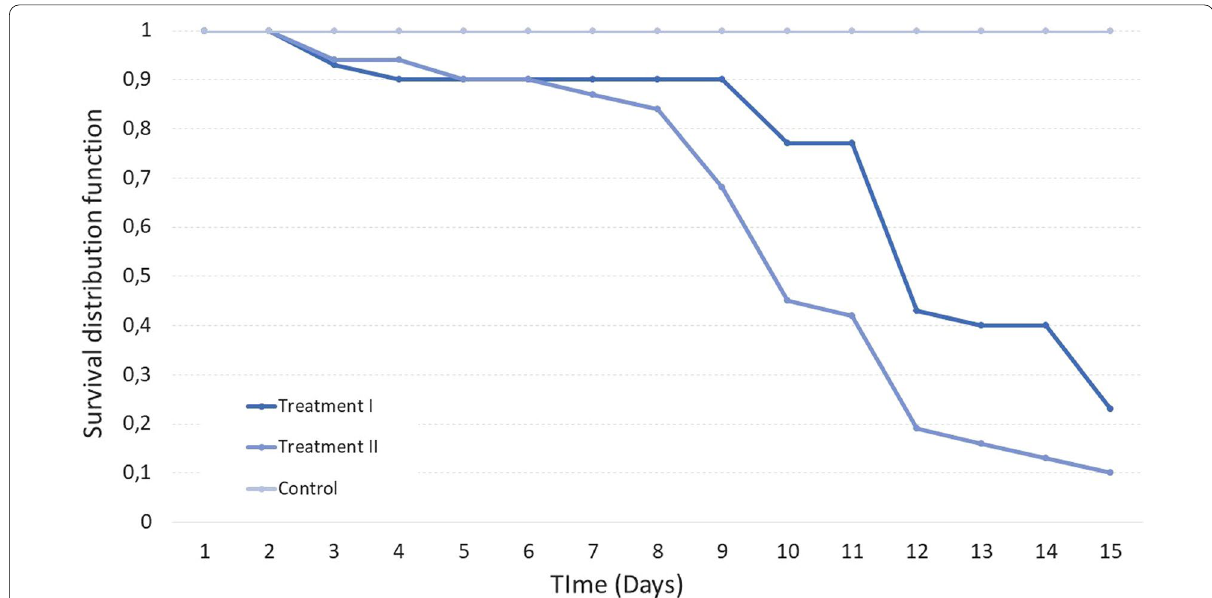
Fig. 4 Kaplan–Meier survival plots of nymphs of Bufonacris clariaziana infected with different baits of Beauveria bassiana and the